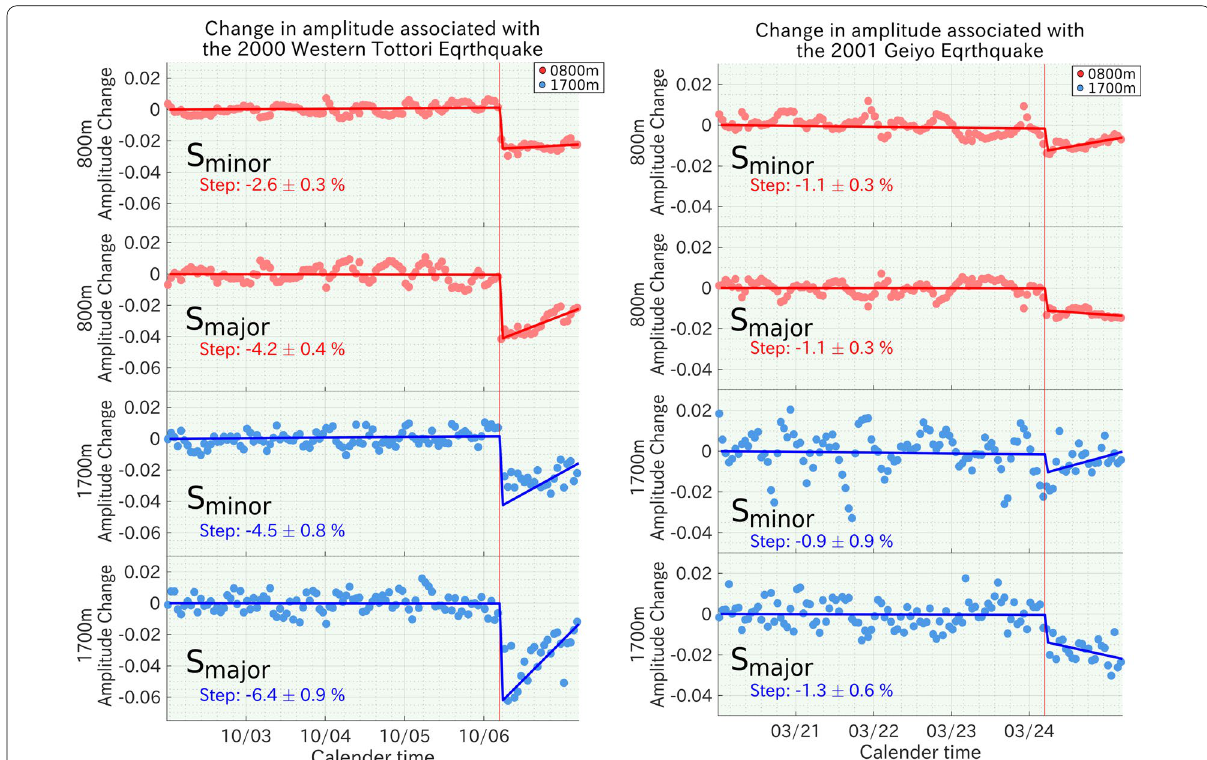
Fig. 12 Coseismic decrease in amplitude in the principal axes of anisotropy. Major and minor axes denote the direction of principal axes with larger and smaller delays in travel time, respectively. Variation in the amplitude (dots) and estimation with our model (solid line) in the principal axes are shown. The top two rows show the results for 800-m sensors and the bottom two rows show that for 1700-m sensors. The left and right panels show the results for the WT and GY earthquakes, respectively. The step and its estimation error are also shown on the left of each panel. The red vertical line shows the time of the